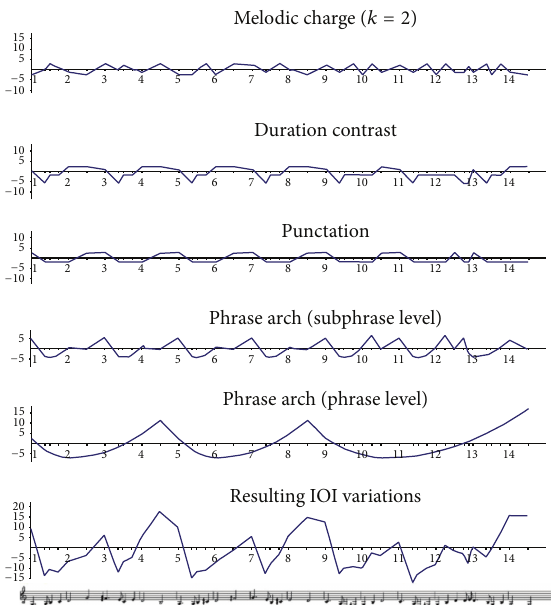
Figure 2: Example of the rules system by KTH application (adapted from [30]). In particular, the figure shows the resulting interonset interval (IOI, i.e., the time from one tone’s onset to that of the next) deviations by applying of four rules (phrase arch, duration contrast, melodic charge, and punctuation) to the Swedish nursery tune Ekorrn satt i granen